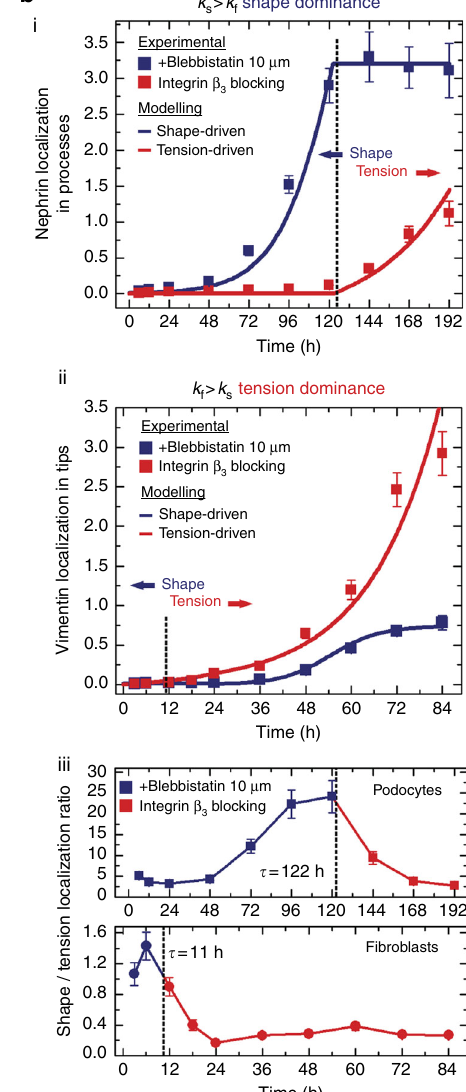
Fig. 4 Experiments agree with the optimal control theory predictions. a Representative immuno fl uorescence images showing the dynamics of (top) nephrin localization in podocytes, and (bottom) vimentin localization in fi broblasts. Cells were plated on channel or rhombus micropatterns, treated with integrin β 3 blocking antibodies or blebbistatin, fi xed at given time points, and stained for nephrin or vimentin (green) as well as F-actin (red). b Experimentally measured localization dynamics in podocyte and fi broblasts for (i) nephrin (podocytes) and (ii) vimentin ( fi broblasts) were fi tted with the temporal order predicted from the optimal control solution (blue and red lines). Both cells show an excellent fi t with the control models. A clear shape-tension transition is revealed which con fi rm the predicted strategy that cells initially respond to shape signals followed by a transition to a tension-driven mechanism. (iii) The localization ratio between shape and tension signals reveals how well the predicted switching time, t agrees with the measured dynamics. Experimental values are given as mean ± SEM; n = 20 cells per timepoint, chosen from four different slides, cultured